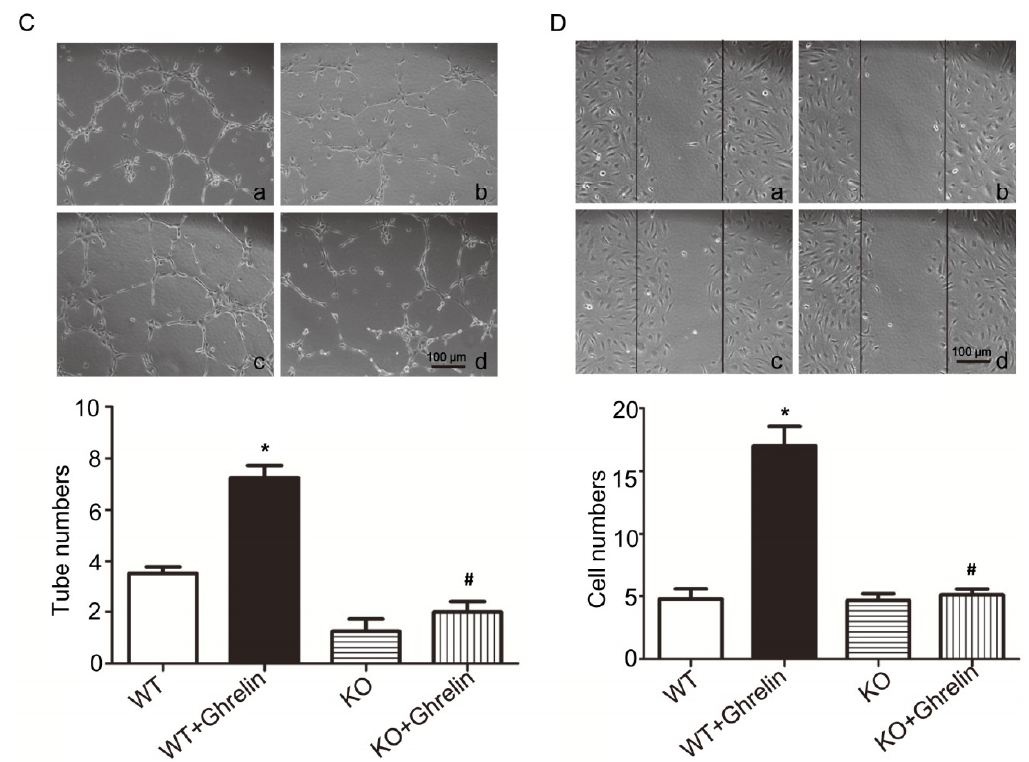
Figure 3. Ghrelin treatment stimulates tube formation and migration of human umbilical vein endothelial cells (HUVECs) and endothelial progenitor cells (EPCs) in vitro . ( A ) In vitro tube formation of HUVECs cultured on Matrigel with ghrelin treatment for 6 h (a, control; b, 10 − 9 M ghrelin; c, 10 − 8 M ghrelin; d, 10 − 7 M ghrelin). Magnification, × 100. Tube-formation assay of HUVEC capillary morphogenesis after ghrelin treatment was shown. The extent of tube formation was determined by counting the tubes in five randomly chosen, low-power fields. ( B ) HUVECs were scratch-wounded and migrating cells were counted after 8 h with ghrelin treatment (a, control; b, 10 − 9 M ghrelin; c, 10 − 8 M ghrelin; d, 10 − 7 M ghrelin), magnification, × 100. Data are expressed as mean ± SD from three independent experiments, each performed in triplicate (* p < 0.05 compared with control group). ( C ) In vitro tube formation of EPCs cultured on Matrigel with ghrelin or N.S. treatment for 6 h (a, wild type EPCs + N.S.; b, Ghsr − / − (KO) EPCs + N.S.; c, wild type EPCs + 10 − 8 M ghrelin; d, KO EPCs + 10 − 8 M ghrelin), magnification, × 100. Tube-formation assay of EPC capillary morphogenesis after ghrelin treatment was shown. The extent of tube formation was determined by counting the tubes in five randomly chosen, low-power fields. ( D ) EPCs were scratch-wounded and migrating cells were counted after 8 h with ghrelin or N.S. treatment (a, wild type EPCs; b, KO EPCs; c, wild type EPCs + 10 − 8 M ghrelin; d, KO EPCs + 10 − 8 M ghrelin), magnification, × 100. Data are expressed as mean ± SD from three independent experiments, each performed in triplicate, * denotes p < 0.05 compared with EPCs from wild type mice without ghrelin administration, # denotes p < 0.05 compared with EPCs from wild type mice with ghrelin administration. To further examine the effects of ghrelin, we used endothelial progenitor cells (EPCs) that were isolated from Ghsr − / − and wild type mice. EPCs were cultured and identified by flow cytometry. EPCs were treated with 10 − 8 M ghrelin and plated on Matrigel and cultured for 4 h. EPCs were also scratch-wounded and migrating cells were counted after 8 h under ghrelin treatment. As shown in Figure 3C,D, tube formation and migration capability were increased by ghrelin in EPCs from wild type mice, but were not seen in EPCs from Ghsr − / −